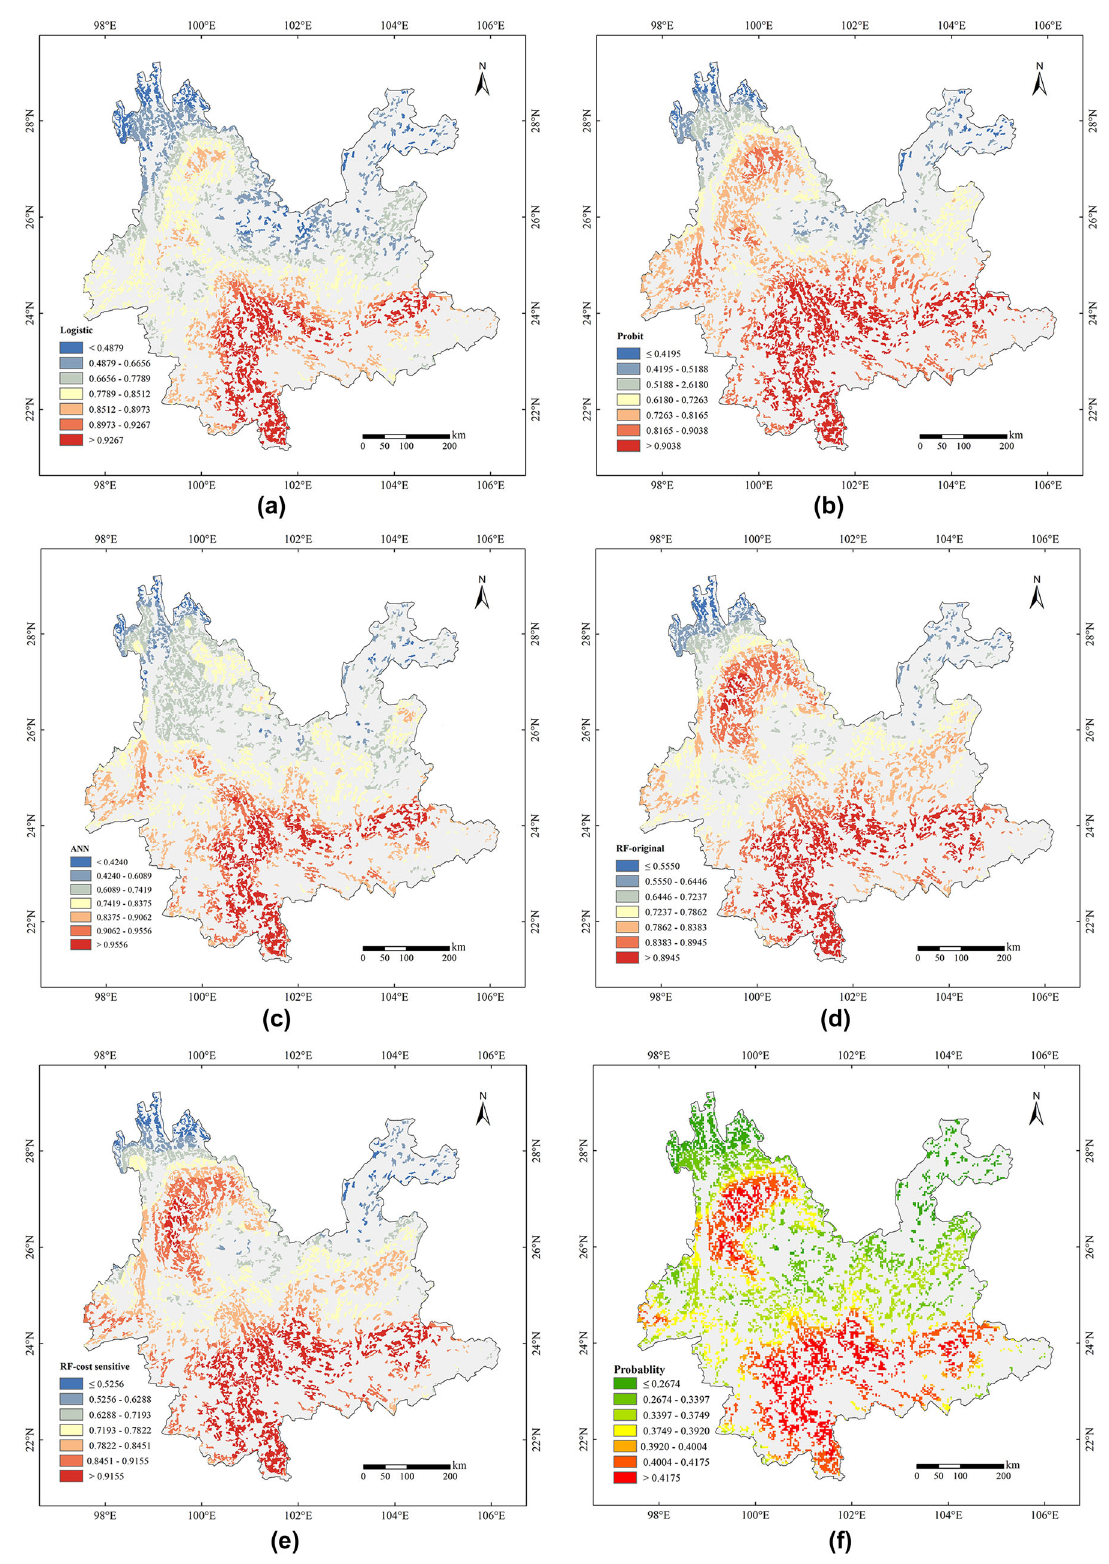
Fig. 7 Spatial pattern of susceptibility for each model: a logistic regression, b probit regression, c the ANN, d RF-original, and e RF-cost sensitive, f depicts ignition